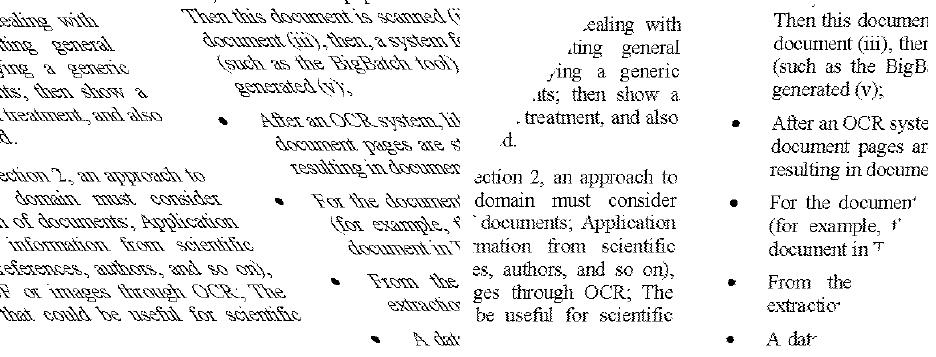
Figure 8. Application of our slant removal technique on sample from BH2M DB ( left ); corrected by −17° ( right ).